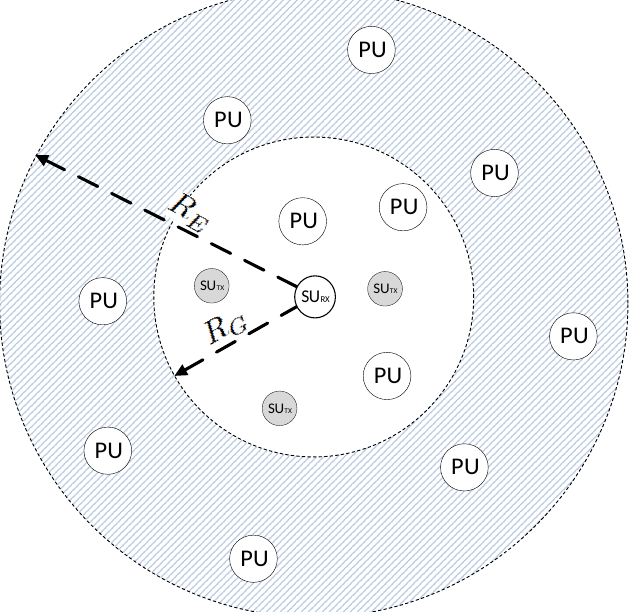
Figure 1. Sensing (white) and interference (gray)